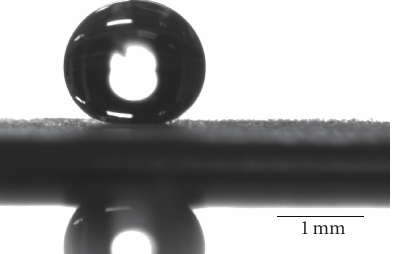
Figure 5: Image of a water droplet on a 12 PDMS-1/PDMS-2 bilayered thin film prepared from water solutions. The contact angle is 159.4 ◦